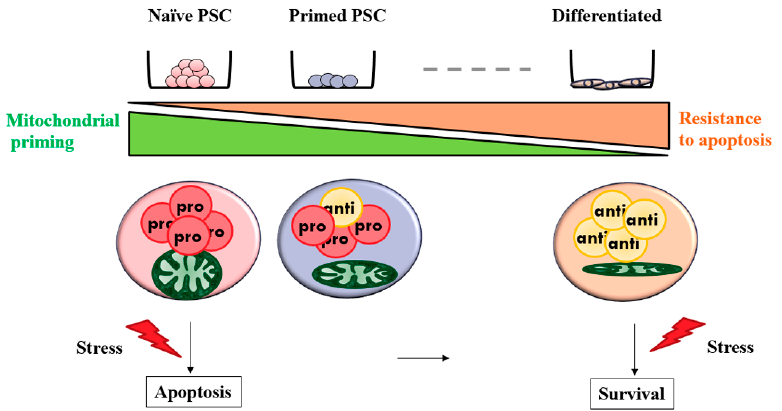
Figure 2. Mitochondrial priming and apoptosis in pluripotent stem cells. PSC; Pluripotent stem cells, Differentiated; differentiated cells, Pro; pro-apoptotic factors, Anti; anti-apoptotic factors.